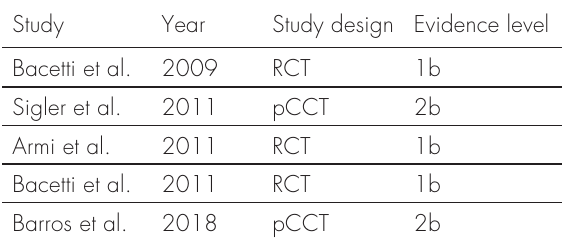
Table IV. Quality assessment of the included